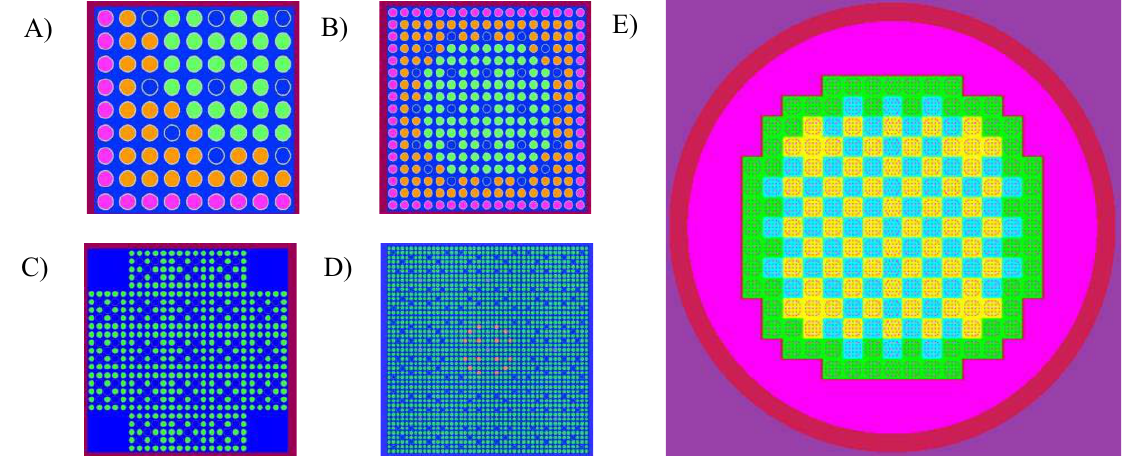
Figure 1. Geometry of 9x9 Fuel Assembly (A), 17x17 Fuel Assembly (B), Small PWR (C), Minicore (D),